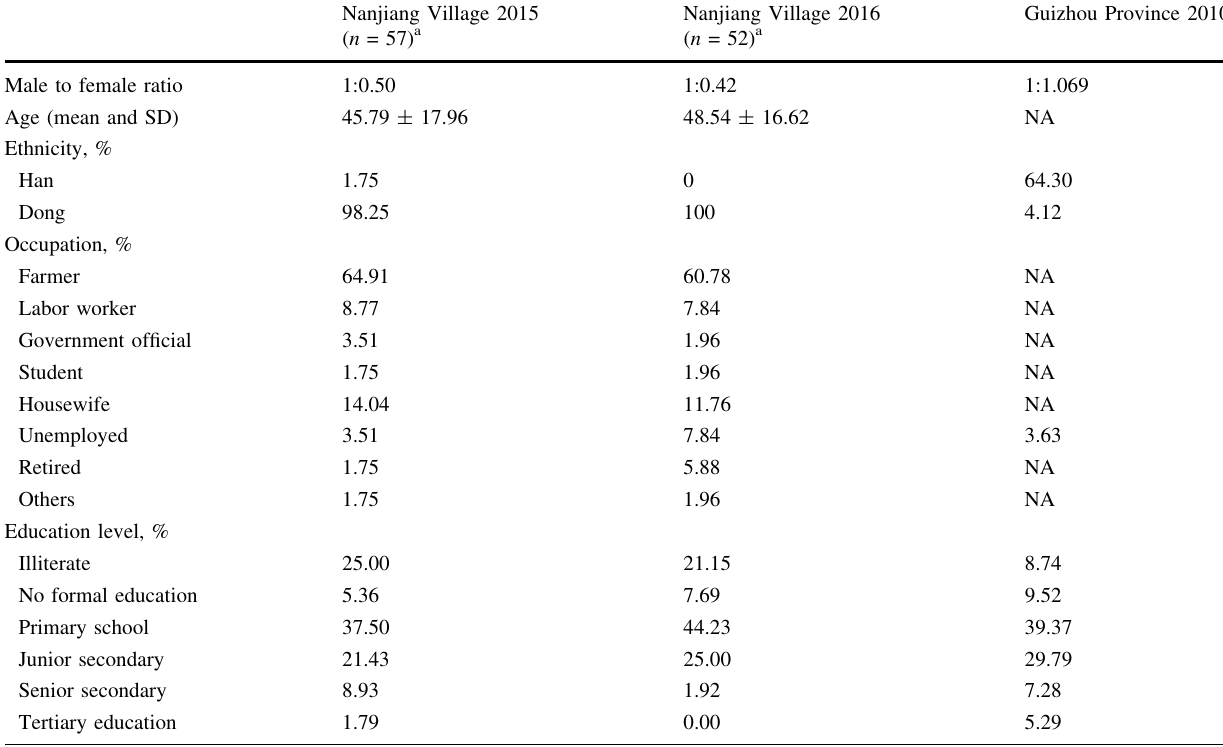
Table 2 Sociodemographic characteristics of the households participating in the 2015 and 2016 fire risk education interventions in Nanjiang Village, Guizhou Province,